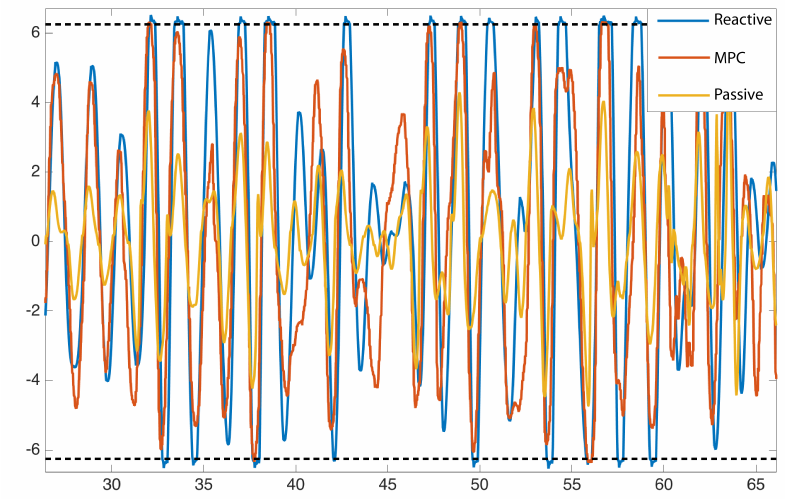
Figure 11. Measured PTO moment [Nm] as a function of time [s] from the wavestar point absorber physical model operating with passive, reactive, model-predictive controllers in sea state